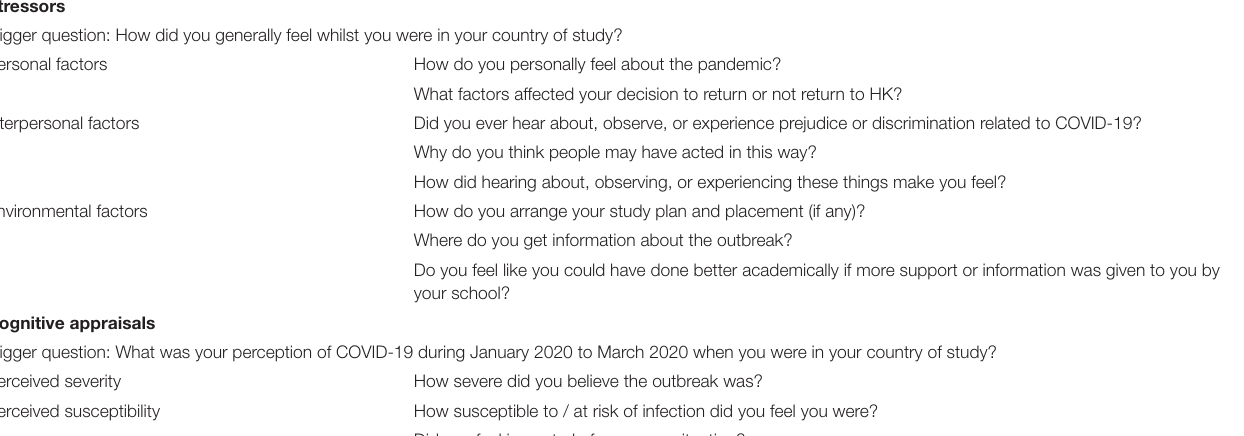
TABLE 1 | Sample questions for the theory-based interviews.